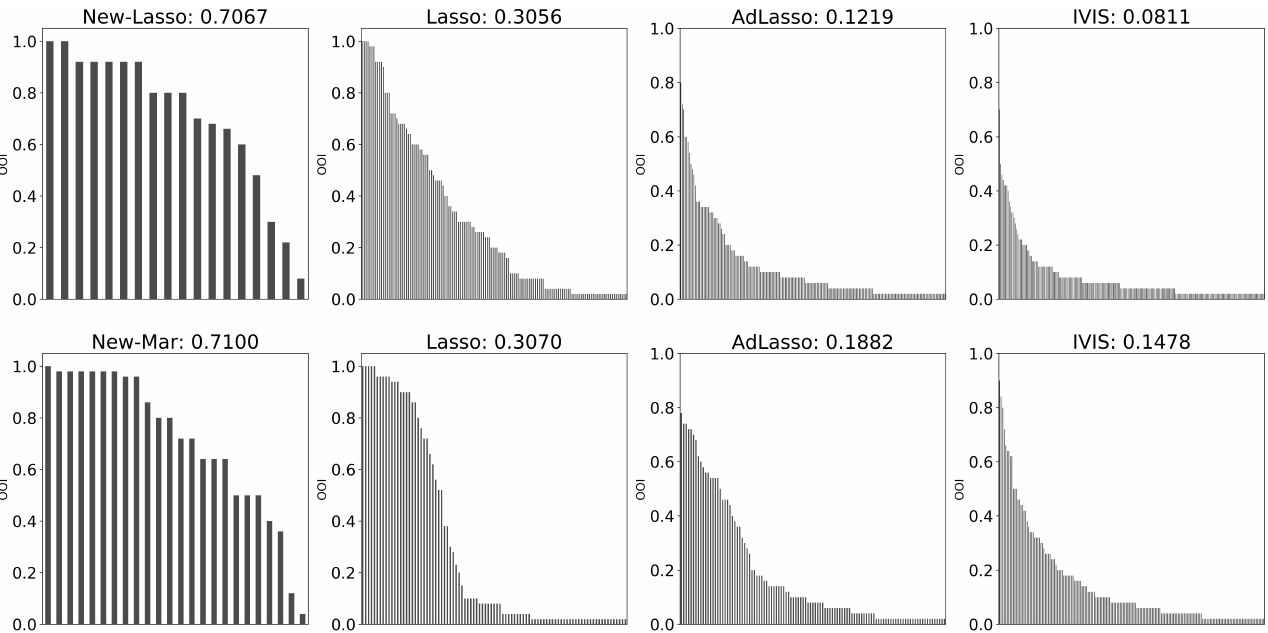
Figure A6. OOIs in the data analysis. Top: SKCM, bottom: